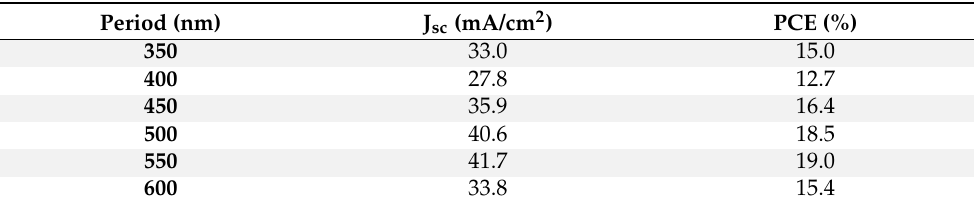
Table 6. Short-circuit current density and overall efficiency for different distances between NWs.